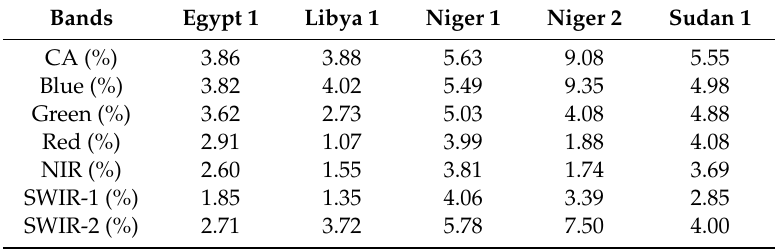
Table 16. Total uncertainties for each PICS absolute calibration